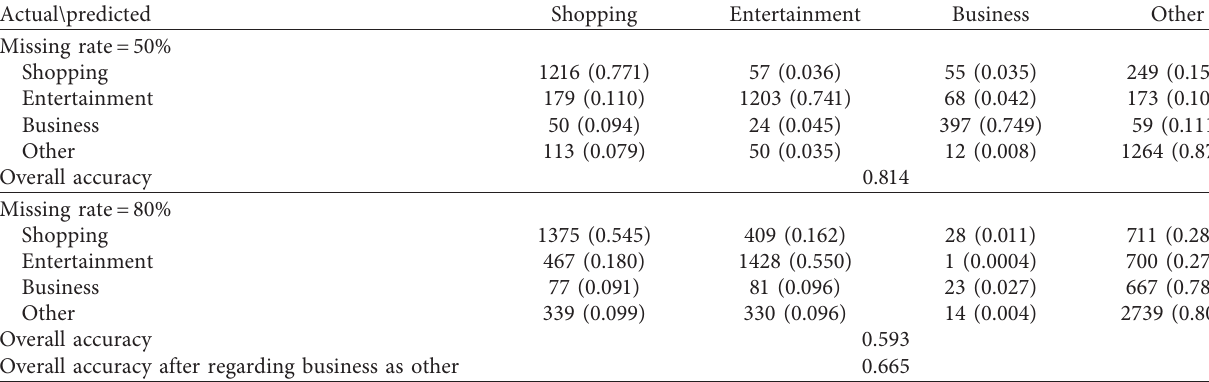
Table 2: Confusion matrices of TCF results.